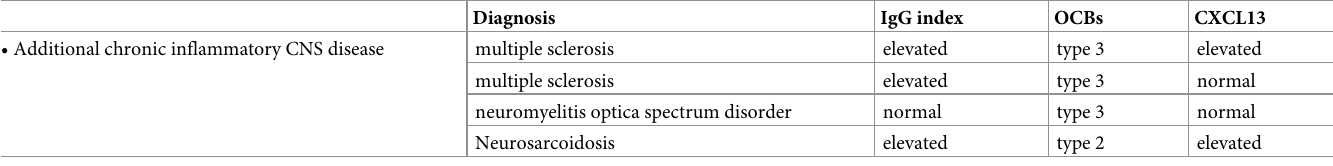
Table 2. Patients with intrathecal IgG synthesis and chronic inflammatory CNS